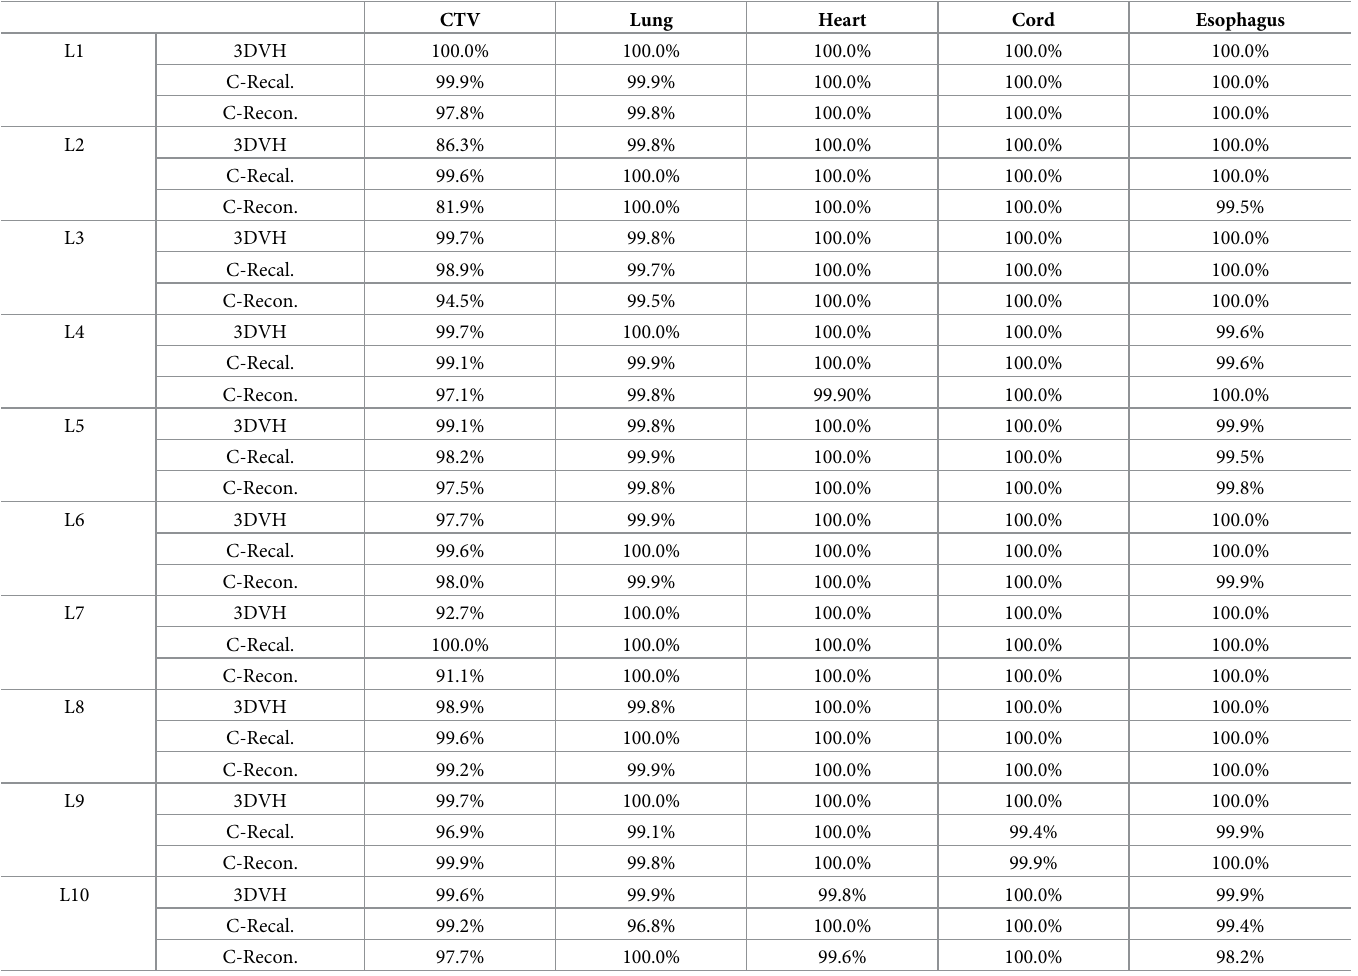
Table 4. Pass rates calculated for the gamma evaluation in the tumor target and OARs compared with a reference TPS dose with the calculated dose in 3DVH and compass (C-Recal.: Compass Recalculation, C-Recon.: Compass Reconstruction) for the lung